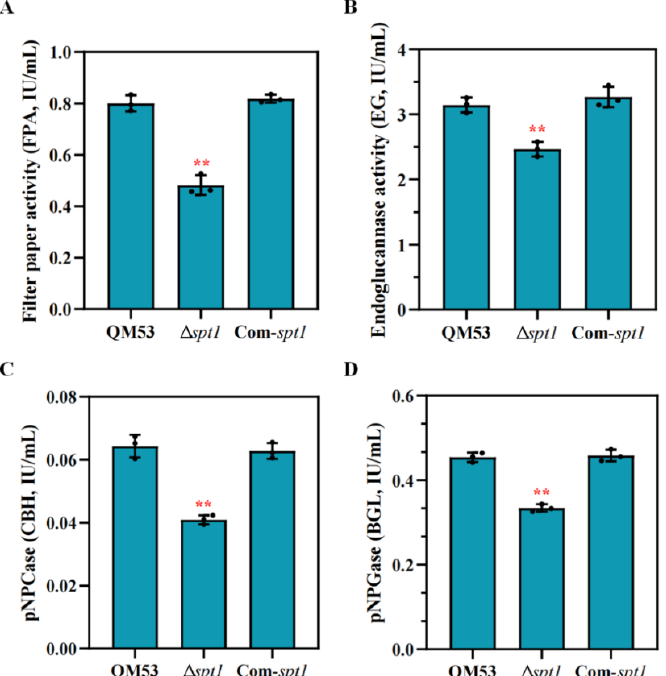
Figure 5. A comparison of cellulase production in T. reesei Δ spt1 , Com- spt1 and the parental strain QM53 during liquid fermentation, using MCC as the carbon source. The filter paper activity ( A ), the endoglucanase (EG) activity ( B ), the cellobiohydrolase (CBH) activity ( C ) and the β -glucosidase (BGL) activity ( D ) were determined in the fermentation broth on the 7th day. The strains were cultured in cellulase-inducing medium containing MCC as the carbon source at 30 °C for 7 days. The values represent the mean of three repeated measurements taken from at least three parallel exper- iments. The error bars refer to the standard deviations (SD). The difference between the parental strain and the recombinant strains was shown by the analysis of ANOVA, followed by the Turkey test. ** p < 0.01.